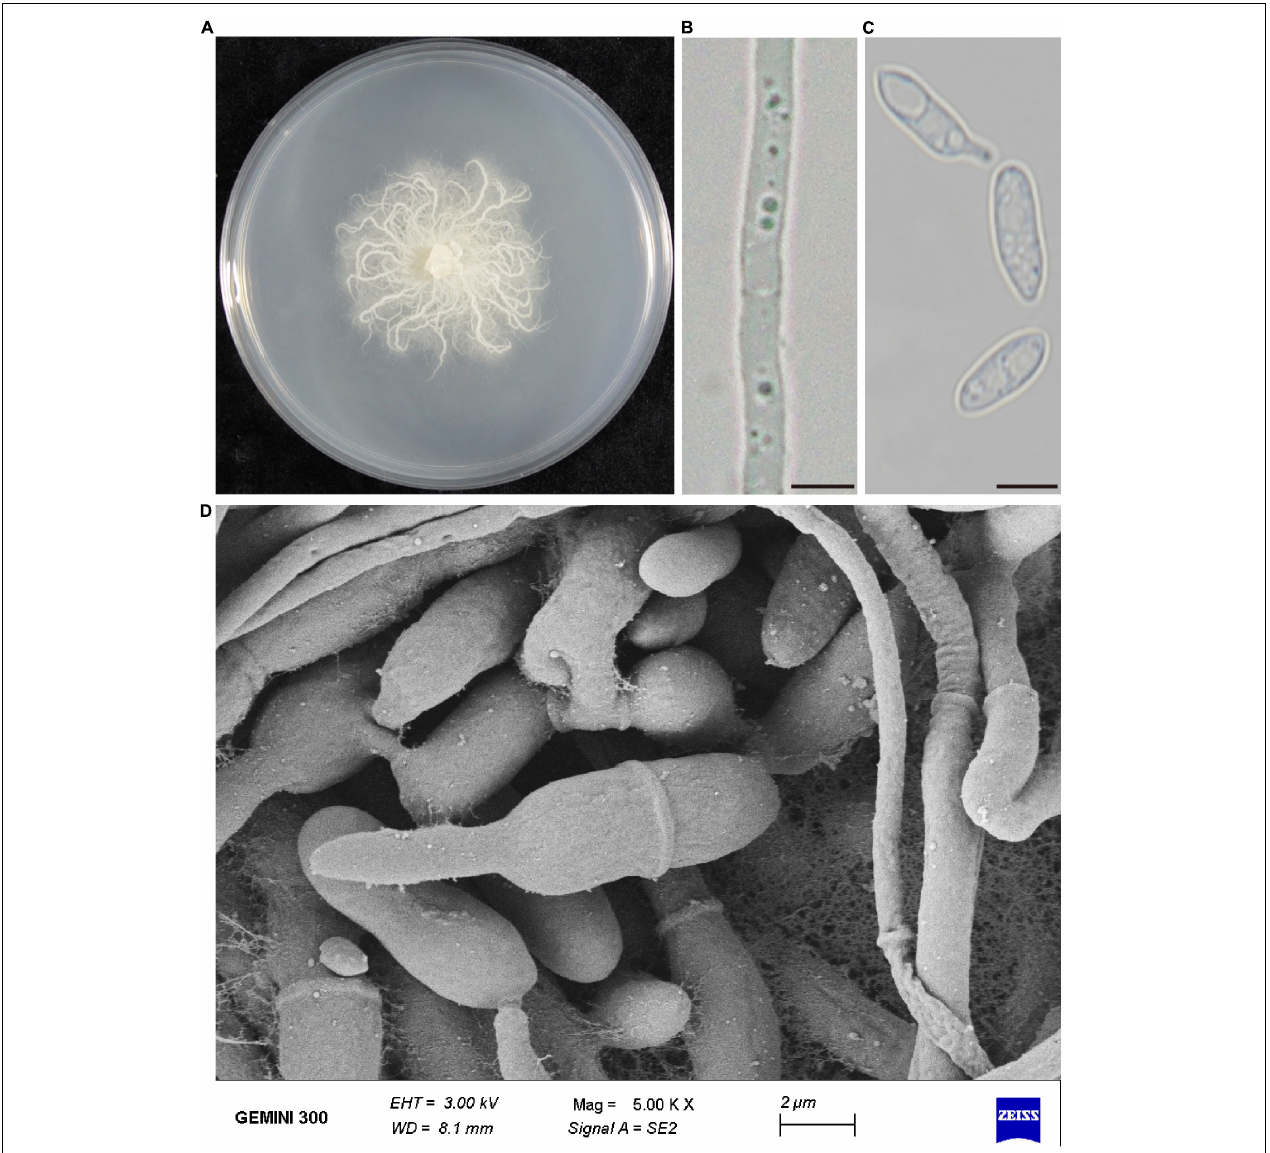
FIGURE 1 | Morphological characteristics of P. oryzae . (A) Fungal colony on PDA after 7 days at 25 ◦ C. (B) Mycelia morphology under the optical microscope. Bar, 5 µ m. (C) Conidia morphology under an optical microscope. Bar, 5 µ m. (D) Scanning electronic micrographs of mycelia and conidia. Bar, 2 µ m.